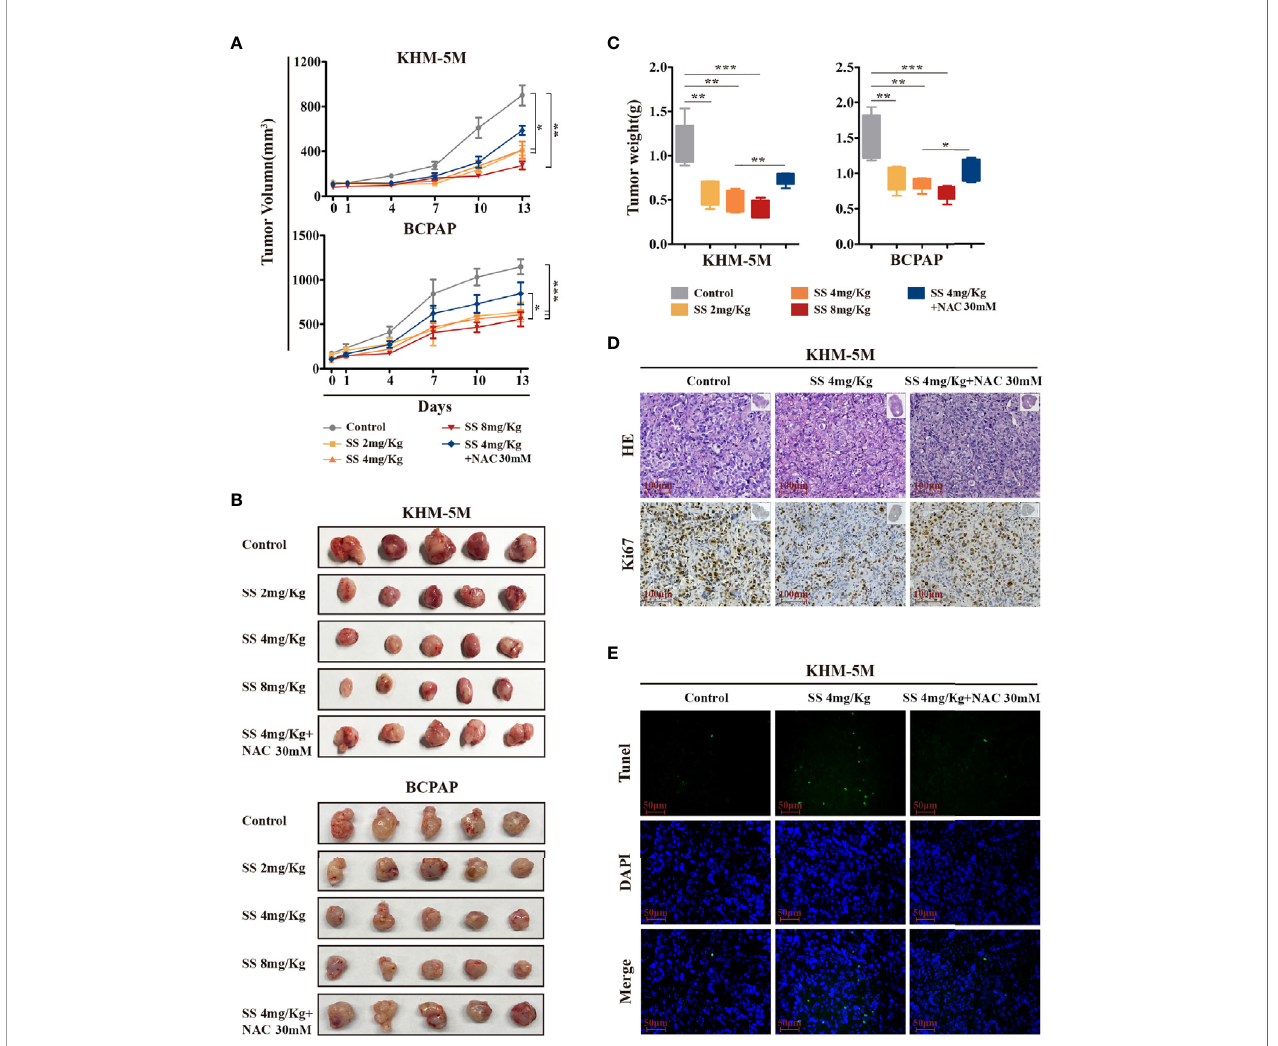
FIGURE 6 | The therapeutic effect of SS in xenograft mouse models. (A) Tumor-bearing mice were treated with 0 – 8 mg/kg SS or SS+NAC for 14 days, and tumor volumes were measured using digital calipers. (B) Tumor tissues were removed and photographed after treatment. (C) Box-whisker plot of tumor weights. (D) Ki-67 staining and (E) TUNEL assay were used to evaluate the proliferation and apoptosis in dissected tumors from different groups. Data are expressed as mean ± SD. SS, sodium selenite; NAC, N-acetylcysteine. *P < 0.05; **P < 0.01; ***P <